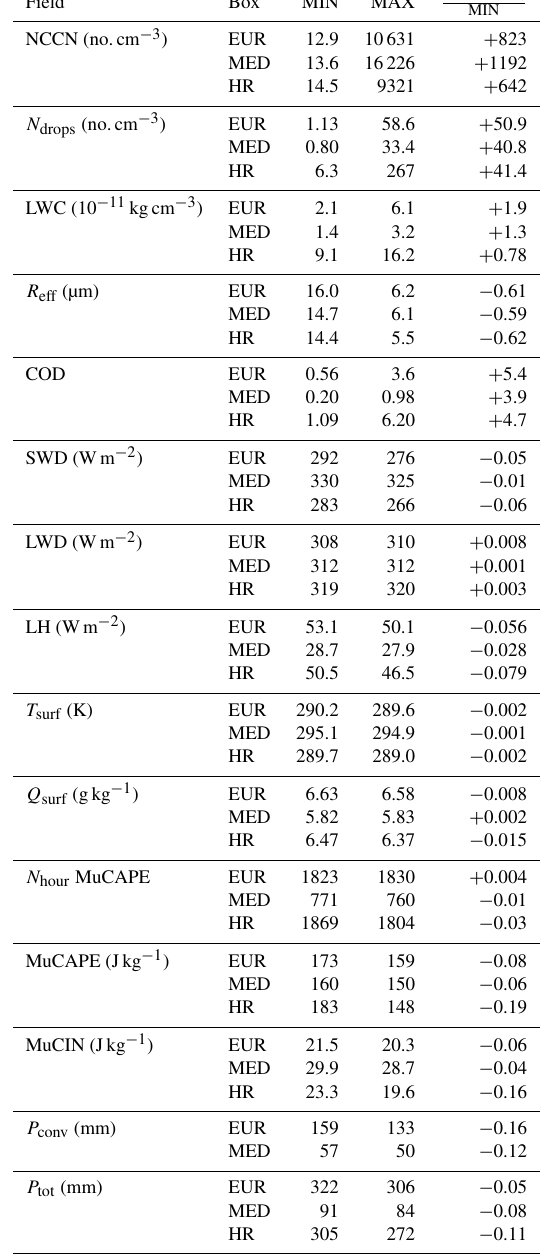
Table 2. Key variables for the MIN and MAX simulations: num- ber of cloud condensation nuclei (NCCN), number of liquid cloud drops ( N drops ), liquid water content (LWC), cloud drops effective radii ( R eff ), cloud optical depth (COD), shortwave downward radi- ations (SWD), longwave downward radiations (LWD), latent heat- ing (LH), surface temperature ( T surf ), surface water vapor mixing ratio ( Q surf ), number of hours per grid point with strictly positive MuCAPE ( N hour MuCAPE), MuCAPE, MuCIN, convective pre- cipitation ( P conv ) and total precipitation ( P tot ). All the values are averaged in space and time over the indicated domain from April to September 2013, except P tot and P conv (precipitation totals aver- aged over space only) and N hour MuCAPE (number of hours aver- aged over space